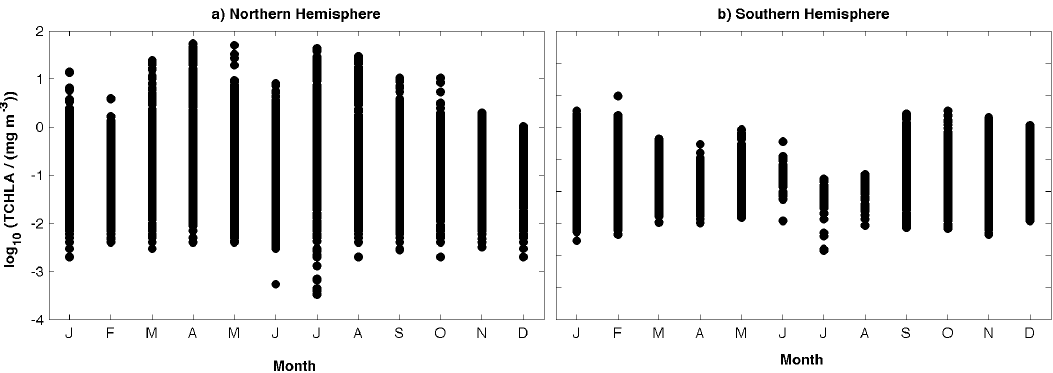
Figure 5. Seasonal distribution of MAREDAT TCHLA values (mgm − 3 ) for the (a) Northern and (b) Southern hemispheres. Data from the equator are included in the Northern Hemisphere panel.